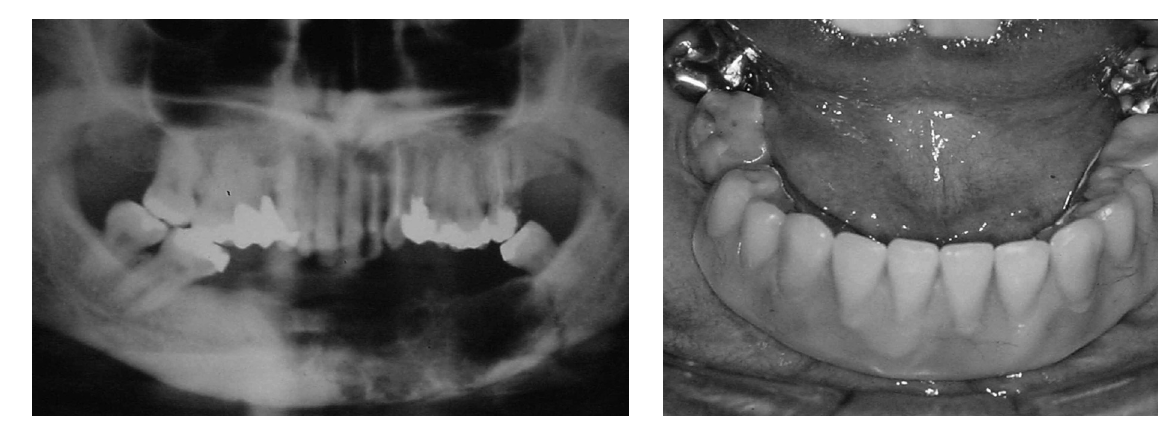
Figure 7 - Panoramic radiograph 10 weeks after the surgery. Image suggest- ing pathological fractures in the left molar region. Teeth within the lesional area were extracted